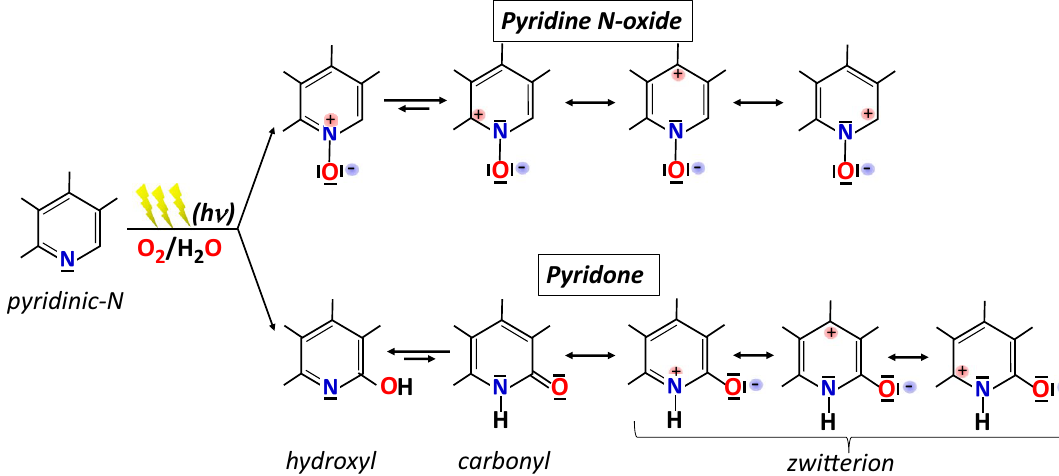
Figure 4. Simplified reaction scheme showing the formation of pyridine N-oxide and pyridone following the light irradiation of pyridinic nitrogen in the graphene network. The protonated tautomeric forms of pyridone, i.e., zwitterions, are involved together with pyridine N-oxide in the delocalization of positive charge throughout the whole π-conjugated system of graphene.